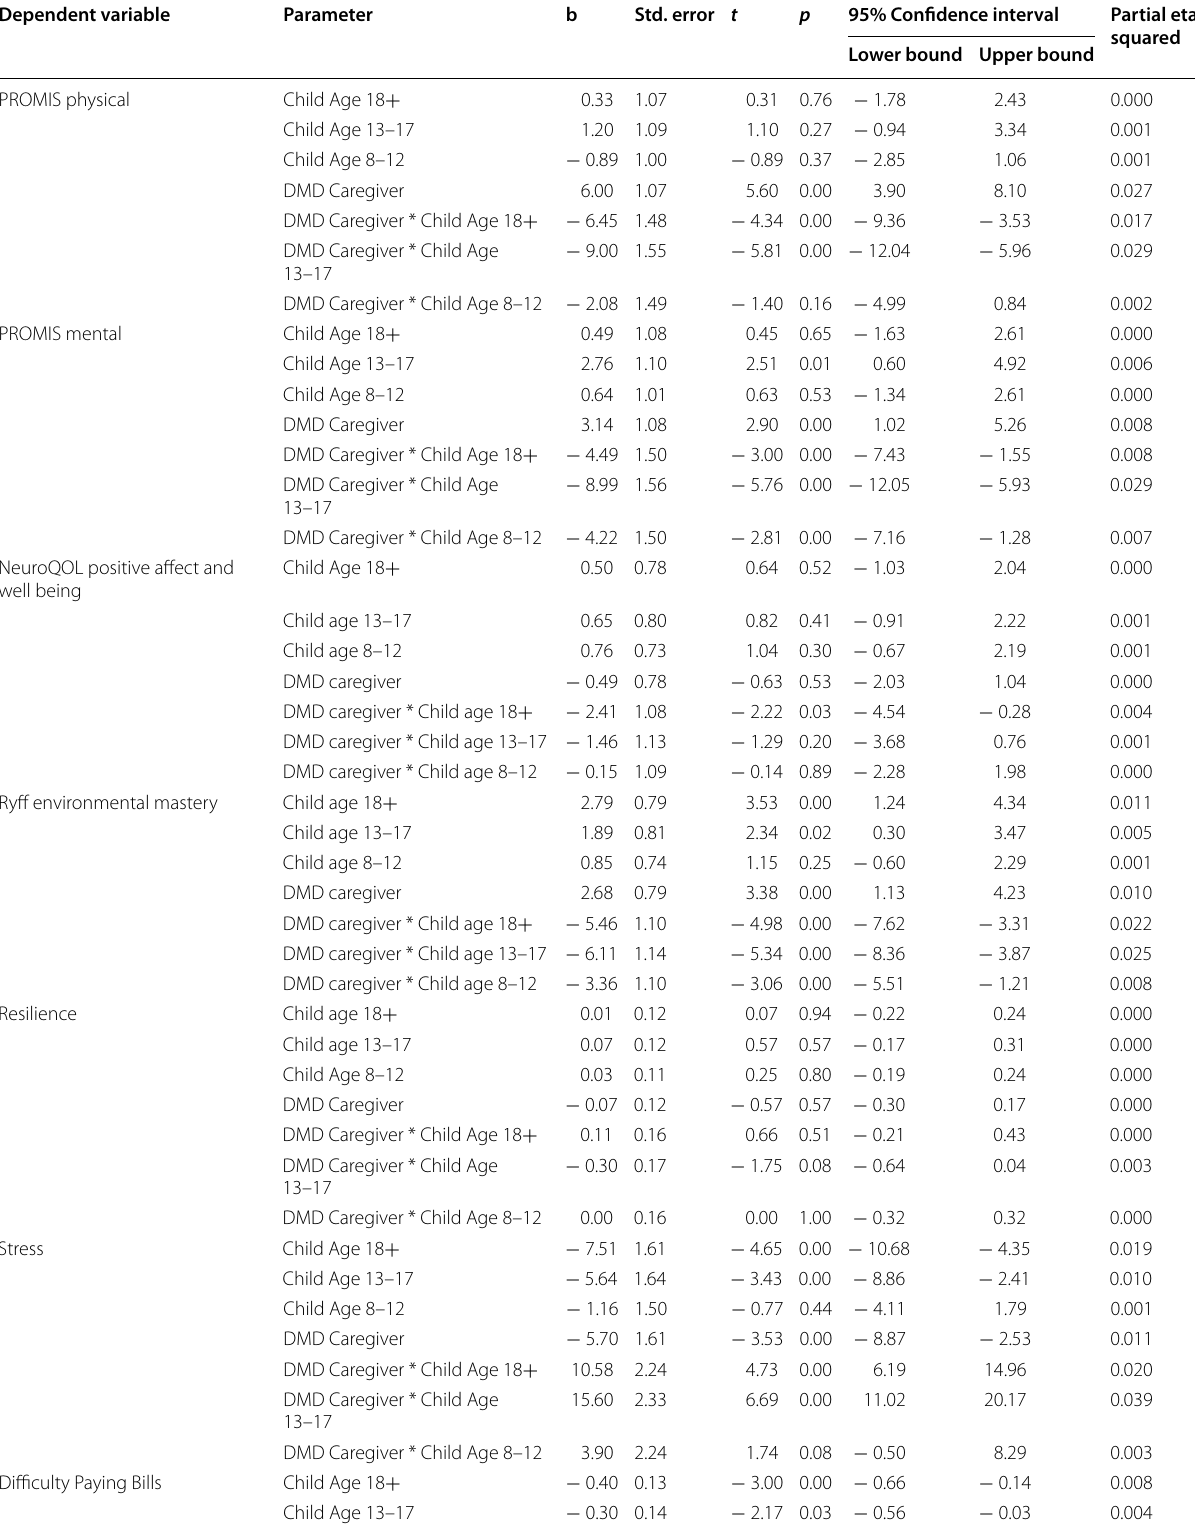
Table 5. Group and Child Age Main- and Interaction-Effects from General Linear Models Adjusted for Propensity Scores Dependent